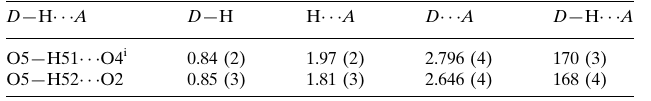
Hydrogen-bond geometry (A˚ , (cid:2)